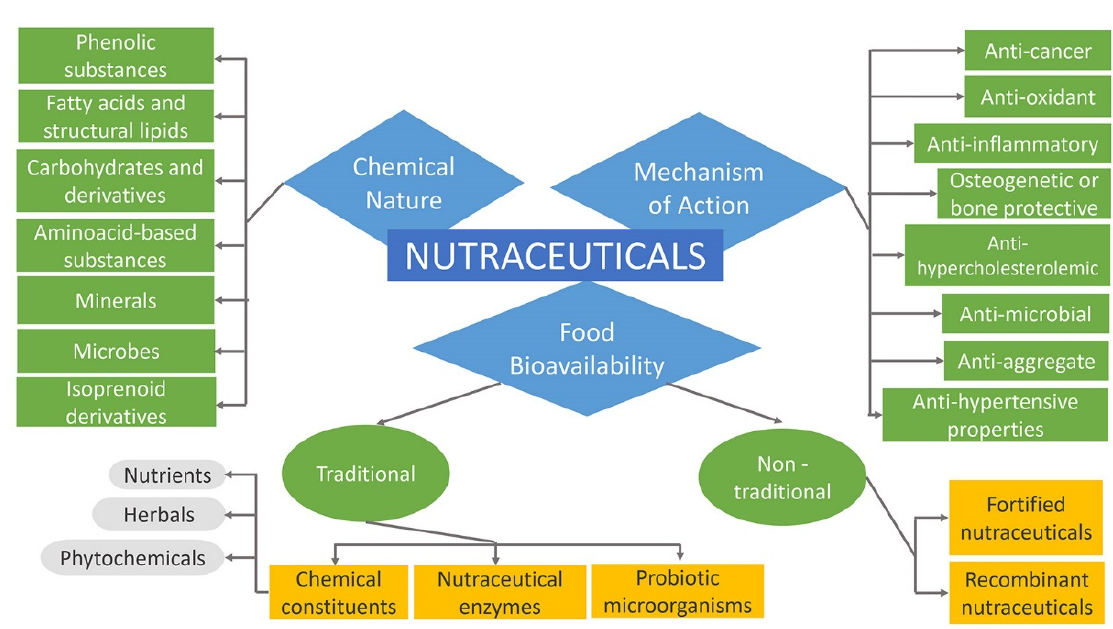
Figure 4. Classification of Nutraceuticals.